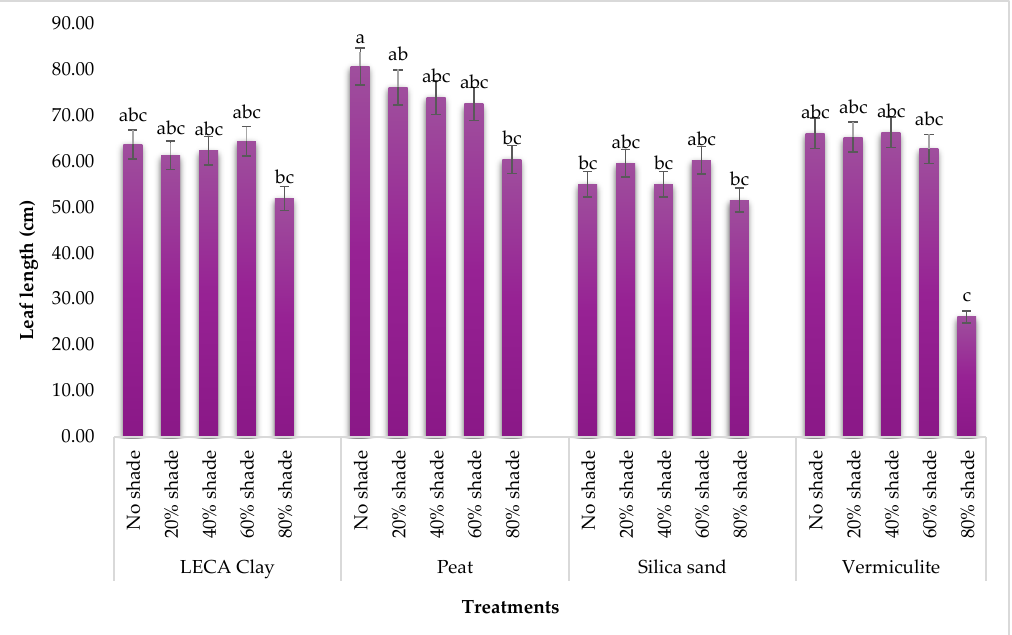
Figure 2. The effect of different growth media and shade levels on leaf length of T. divaricata . Means at the same column followed by the same letter do not differ by Tukey ’ s test ( p > 0.05).